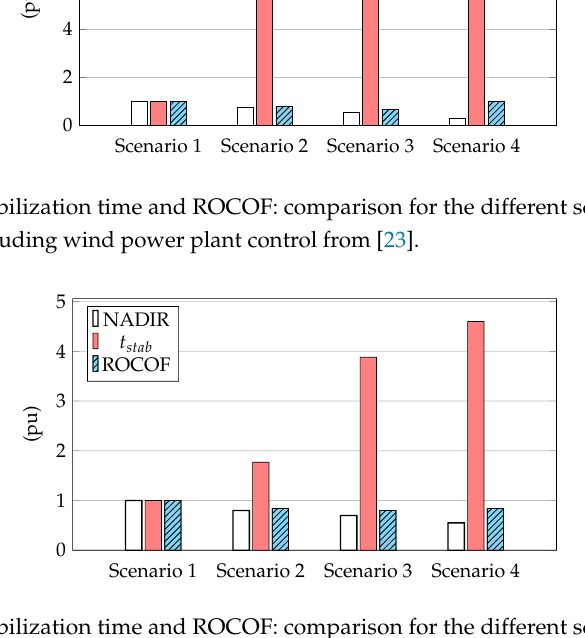
Figure 20. NADIR, stabilization time and ROCOF: comparison for the different Figure 20. Nadir, stabilization time and ROCOF: comparison for the different scenarios considering ∆ P L = 0.050 and including the proposed wind power plant